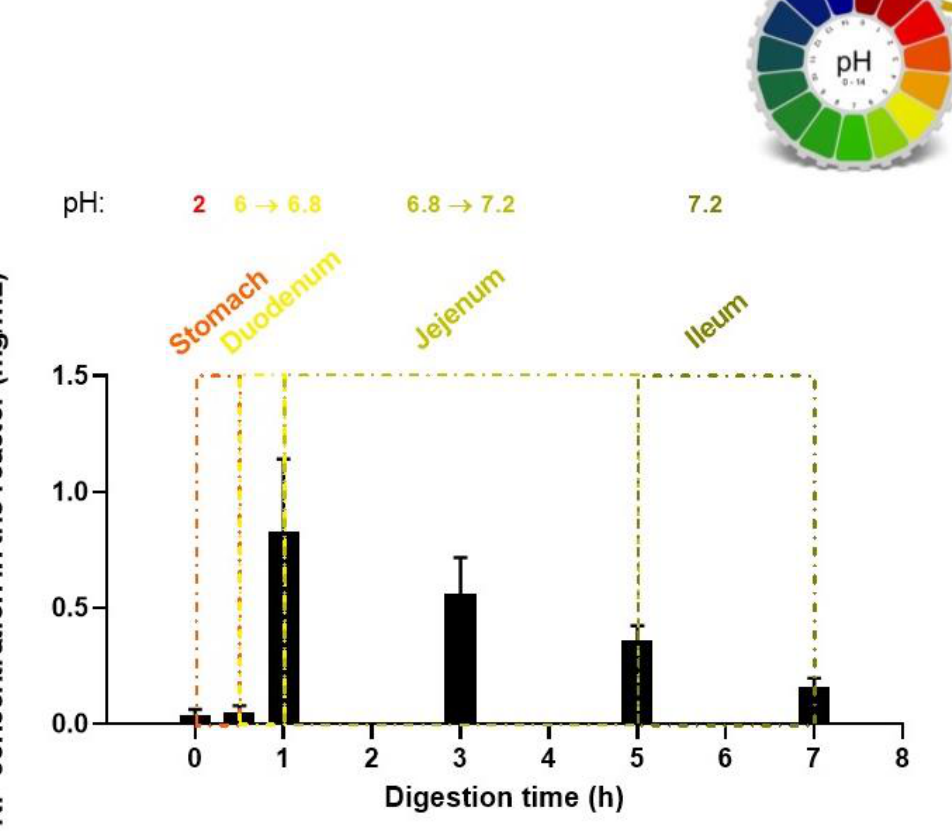
Figure 6. Release of PC conjugate during in vitro dynamic digestion.